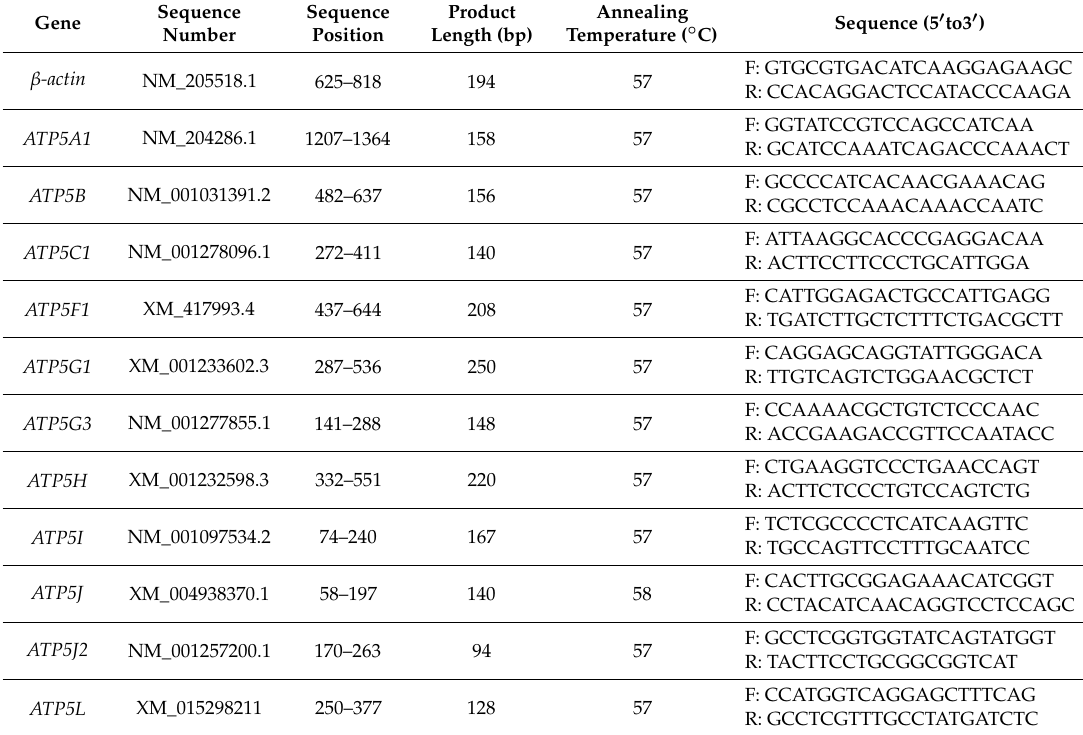
Table 3. Primer sequences for